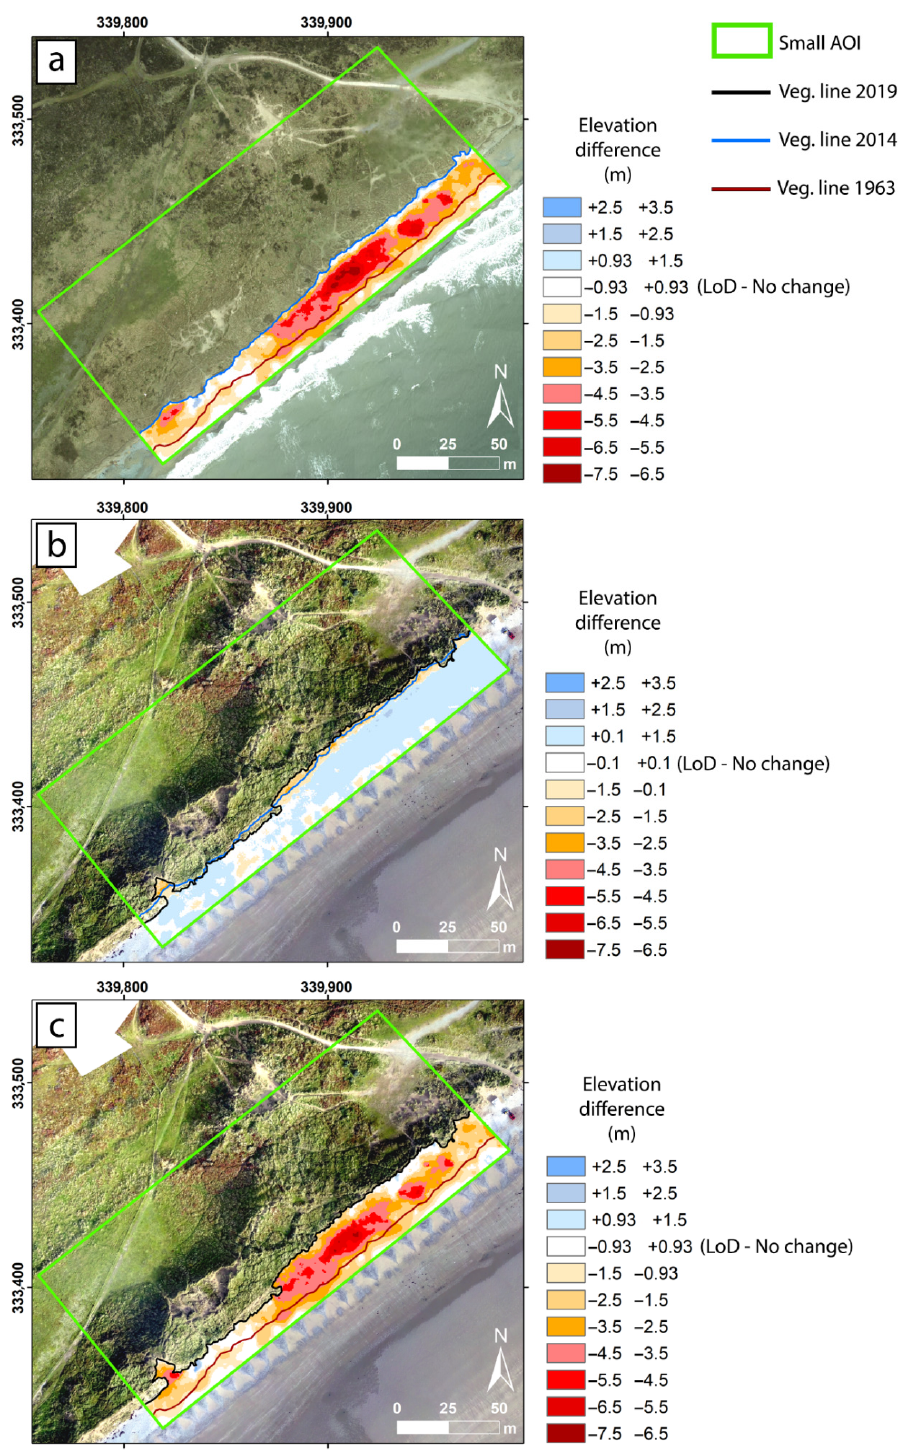
Figure 9. DEMs of difference (DoDs) in the areas between the seaward limit of the small area Of interest and each shoreline (i.e., stable vegetation line): ( a ) geomorphic changes from 1963 to 2014 superimposed on the orthophoto produced from the 2014 light detection and ranging dataset; ( b ) geomorphic changes from 2014 to 2019 superimposed on the orthophoto derived from the structure-from-motion (SfM) process of the 2019 unmanned aerial vehicle (UAV) dataset; ( c ) geomorphic changes from 1963 to 2019 superimposed on the orthophoto derived from the SfM process of the 2019 UAV dataset. Graticules are in TM75/Irish Grid (transverse mercator)